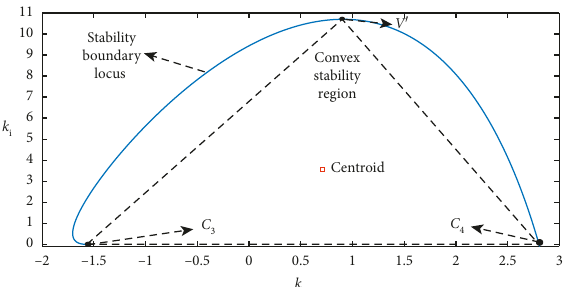
Figure 15: Convex stability region and centroid of the PI controller in example D.